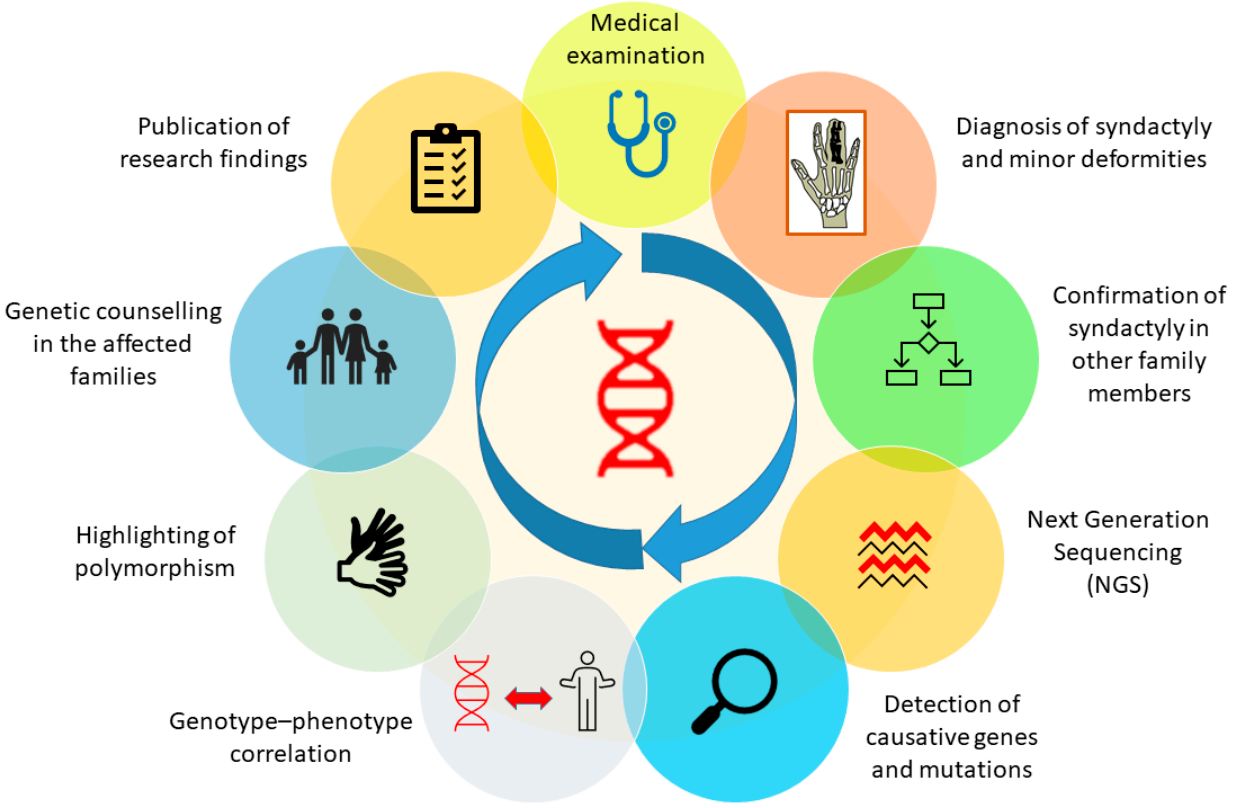
Figure 4. Genetic analysis procedure to attain a clearer genotype-phenotype correlation in all types of syndactyly.